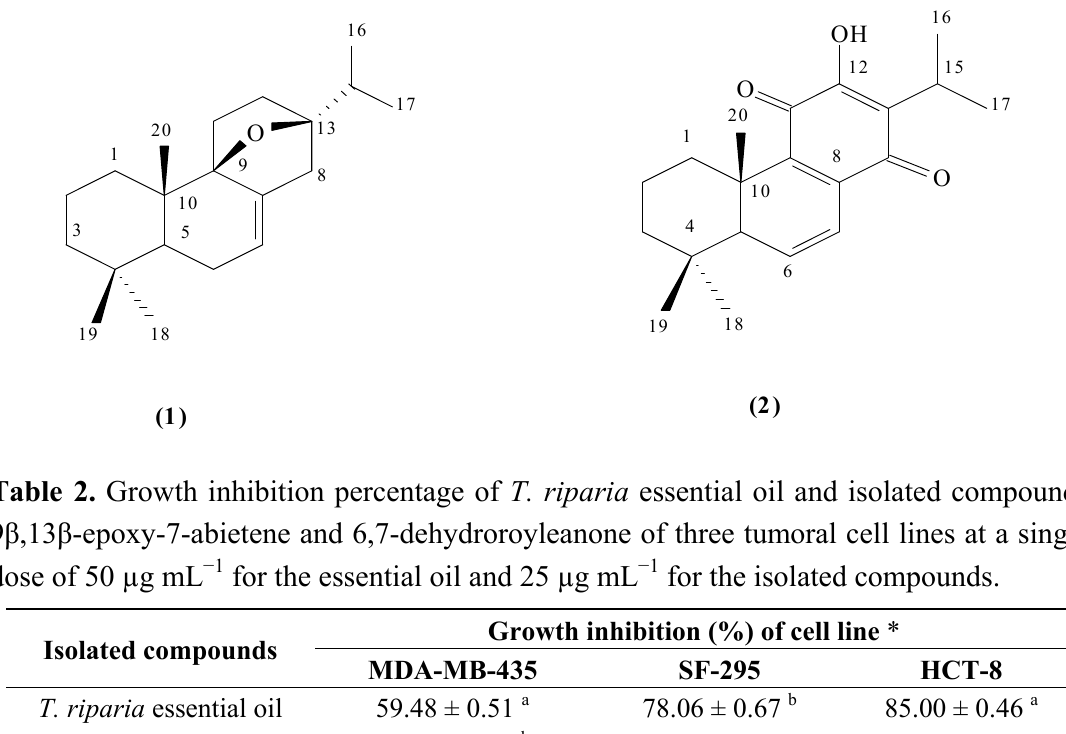
Figure 3. Structural formula of compounds 9 β ,13 β -epoxy-7-abietene ( 1 ) and 6,7-dehydroroyleanone ( 2 ).